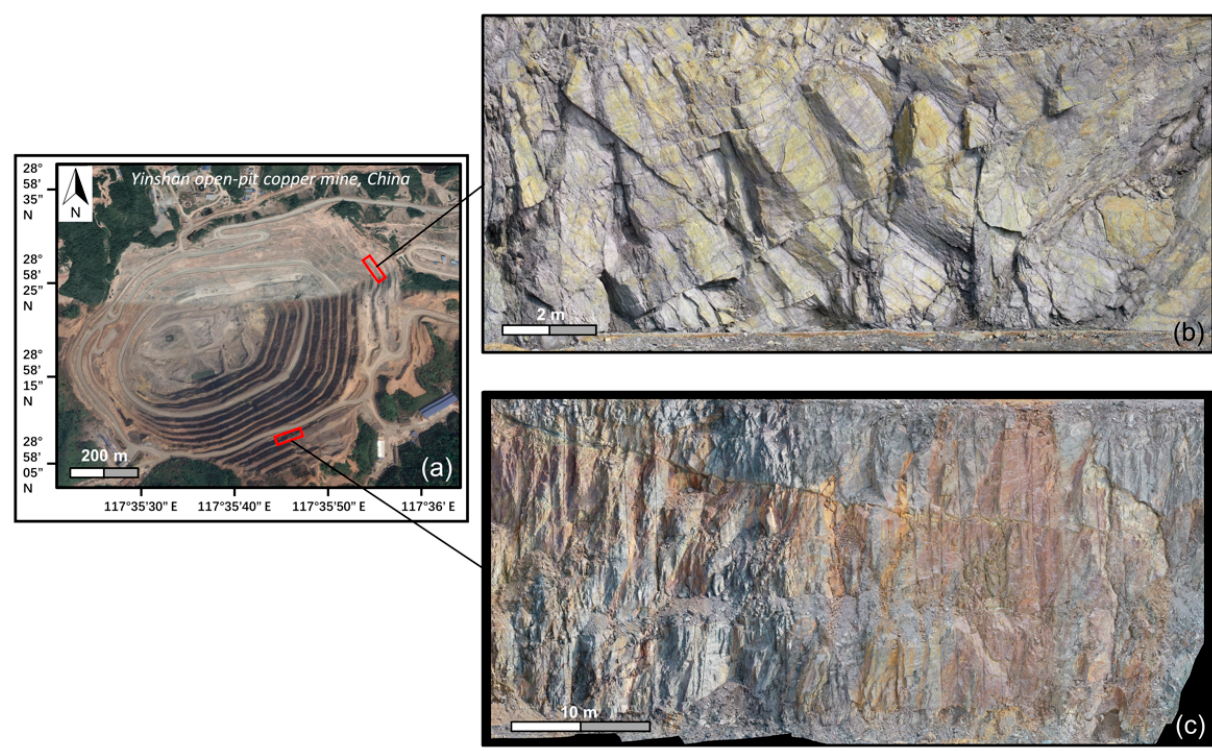
Figure 2. ( a ) Site map of Yinshan open-pit copper mine extracted from Google Earth. ( b ) Orthophoto of the eastern slope generated from UAV photogrammetry. ( c ) Orthophoto of the southern slope generated from UAV photogrammetry.